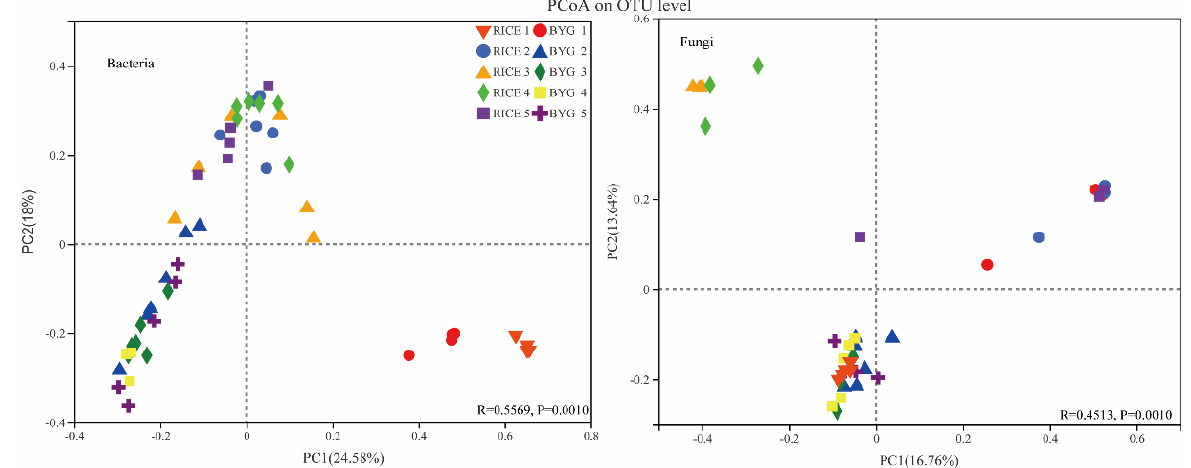
Figure 2. Principal coordinate analysis (PCoA) based on Bray–Curtis dissimilarity between the rice and barnyardgrass for endophytic bacteria and fungi in roots at different growth stages. PCoA of the unweighted UniFrac distance matrix representing differences in community structure of rice and barnyardgrass microcosms at five growth stages. Note: RICE1-5 and BYG1-5 represent the rice samples and barnyardgrass samples, collected from five different growth stages (BBCH 17, 24, 37, 45, and 57).